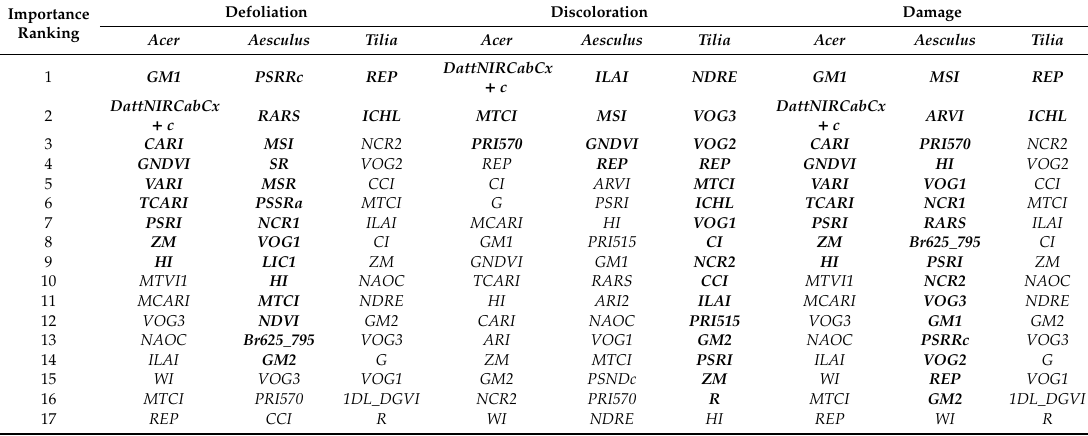
Table A2. The 17 most important indices in HSI models (scenario 2) for tree crown defoliation, discoloration and damage (i.e., combination of defoliation and discoloration) classification. The indices used in the final classification models (according to the forward selection method; Section 2.6.3) are highlighted in bold. The explanation of the indices abbreviations can be found in Table